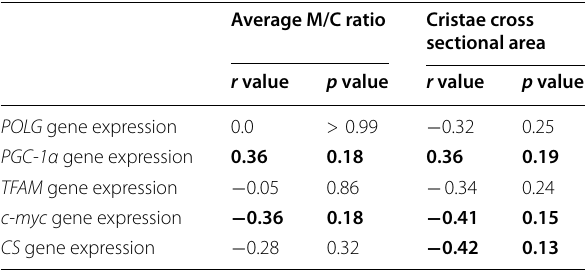
The bold typeface indicates p -values approaching significance POLG Polymerase γ, TFAM Mitochondrial transcription factor A, CS Citrate synthase, r Spearman correlation